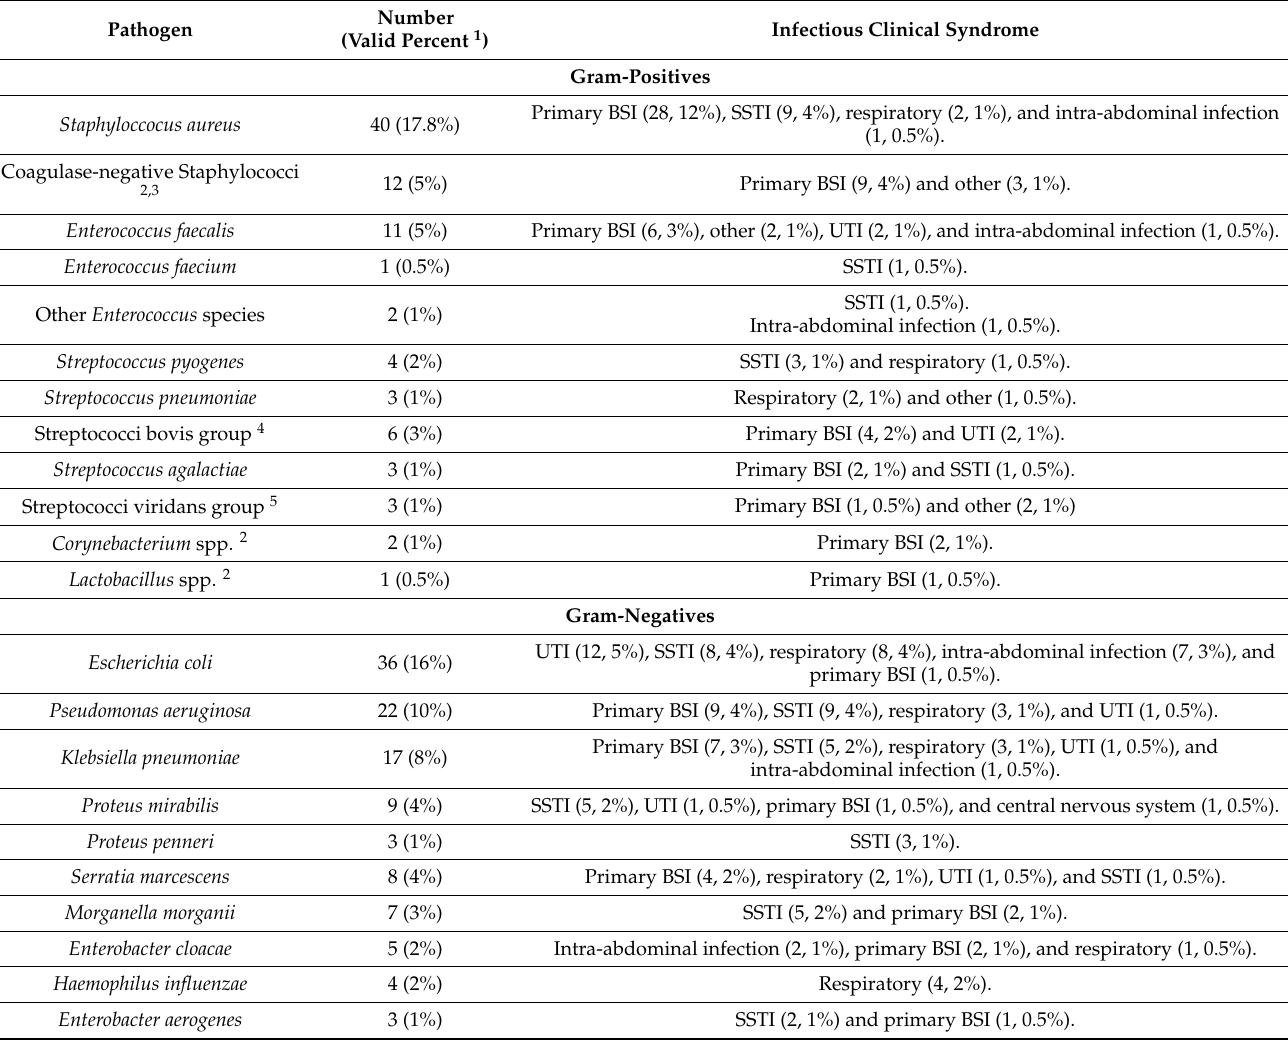
Table 1. Chronic ambulatory hemodialysis patients with microbiologically confirmed sepsis